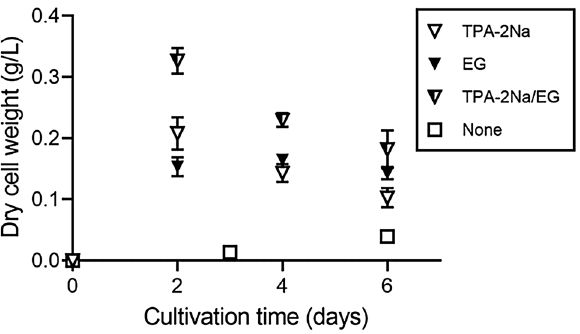
Figure 5. Growth of I. sakaiensis on poly(ethylene terephthalate) (PET) monomers. The cells were cultured with or without 0.5 w/v% disodium terephthalate (TPA-2Na), 0.5 w/v% ethylene glycol (EG), and a mixture